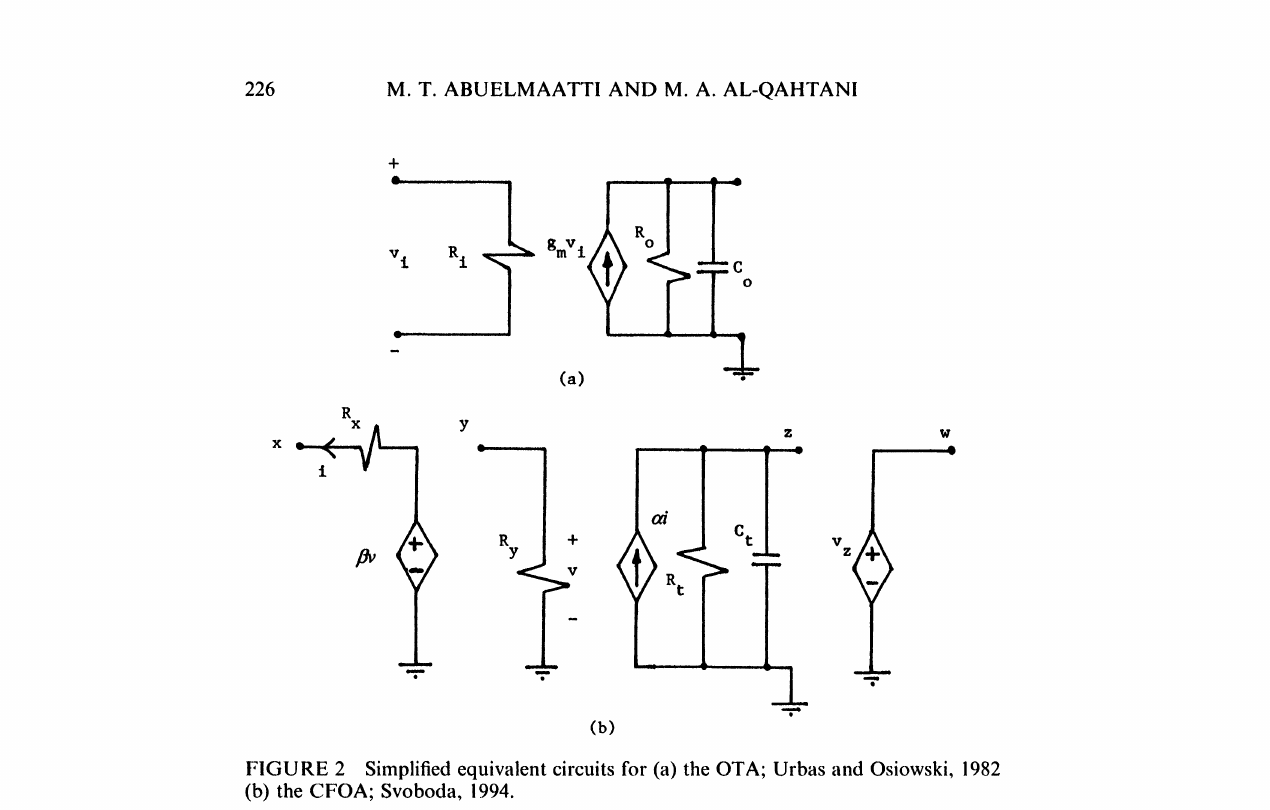
FIGURE 2 Simplified equivalent circuits for (a) the OTA; Urbas and Osiowski, 1982 (b) the CFOA; Svoboda,